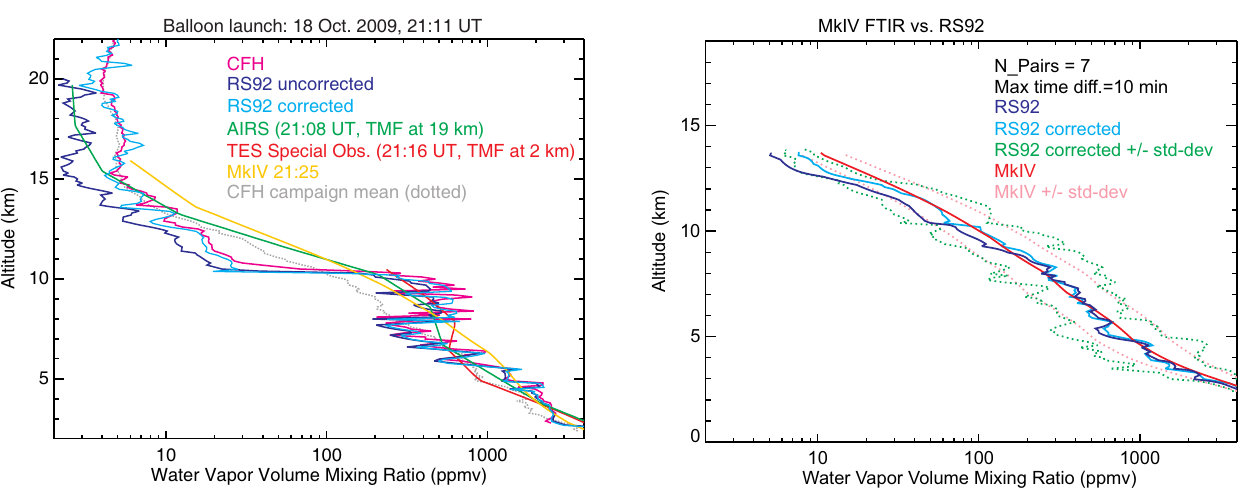
Fig. 10. Campaign-mean water vapor mixing ratio profiles, and standard deviations, measured simultaneously by the ground-based FTIR MkIV and the Vaisala RS92 PTU radiosondes (7 coinci-